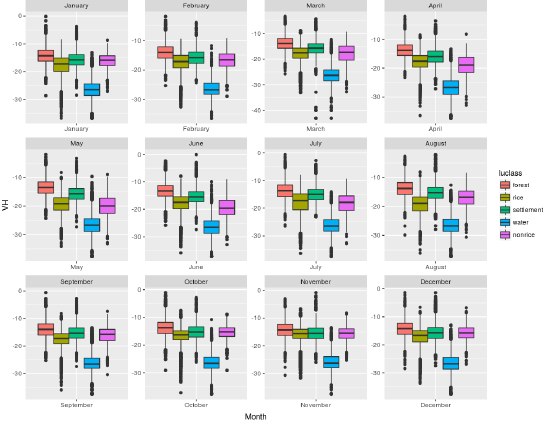
Figure 3. Box Plot for LU/LC Classes in VH Polarization